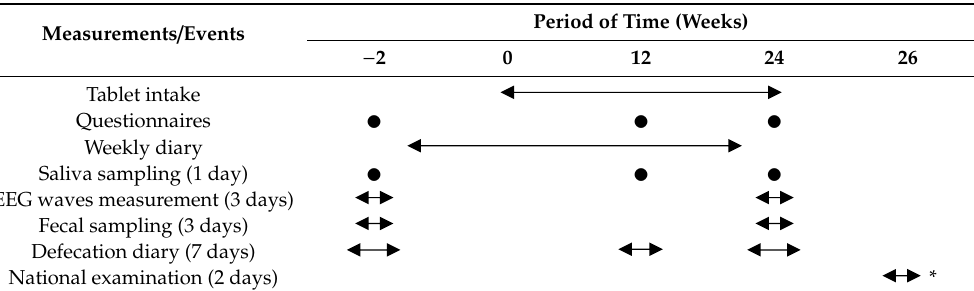
Table 1. Experimental schedule.